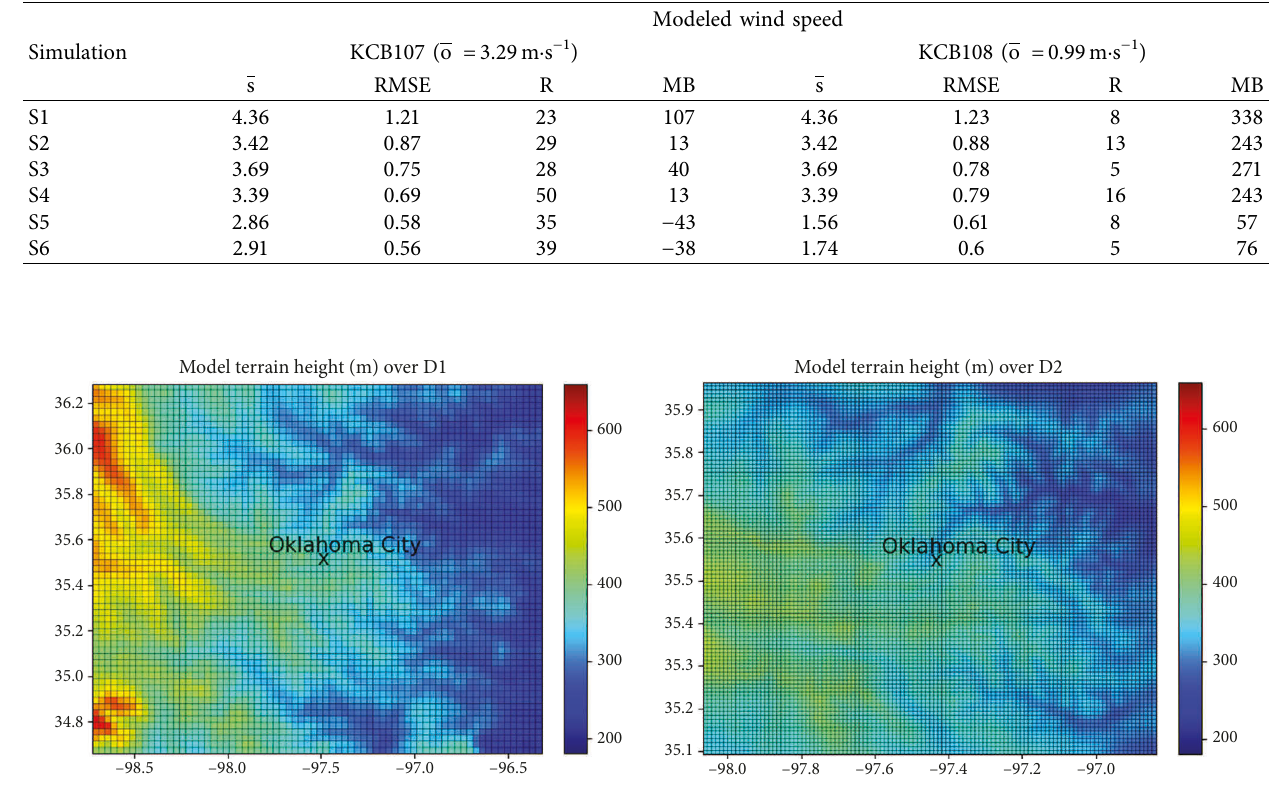
Figure 7: Left panel: Model’s terrain height over D1. Right panel: Model’s terrain height over D2.